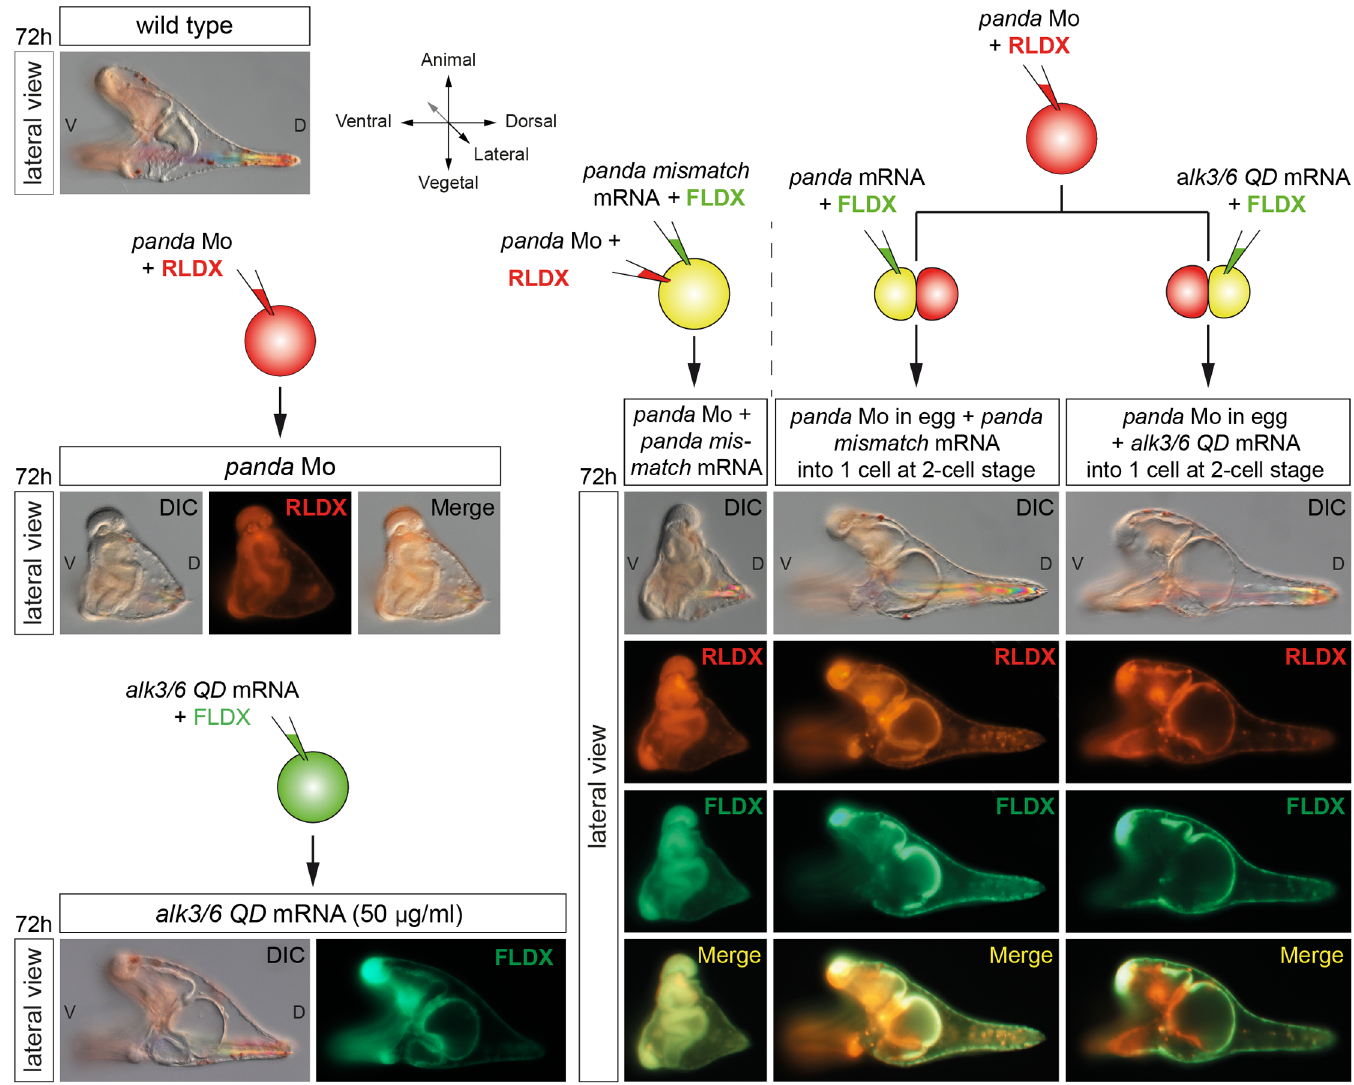
Fig 9. Panda activity has to be provided locally to efficiently rescue panda morphants. Differential interference contrast (DIC) and fluorescence images of embryos injected with a panda morpholino into the egg and then with panda mRNA either into the egg or into one blastomere at the two-cell stage. While providing Panda activity into the egg does not rescue D/V polarity, injection of panda mRNA or of low doses (50 μ g/ml) of mRNA encoding the activated form of Alk3/6 (Alk3/6QD) into one blastomere at the two-cell stage fully rescues D/V polarity of panda morphants. LV, lateral view; V, ventral; D,